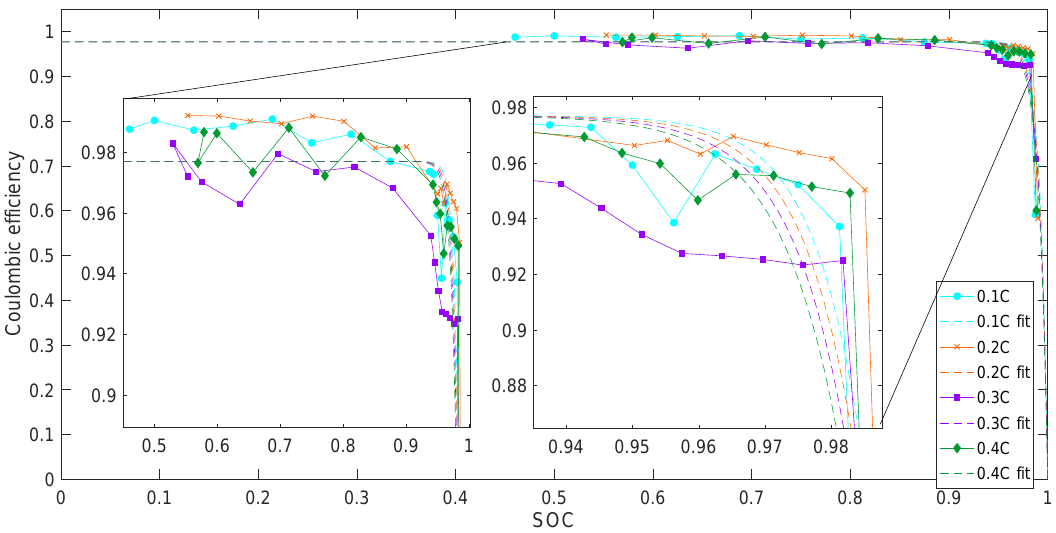
Figure 12. Measured Coulombic efficiency of VRLA battery with SOC and with different